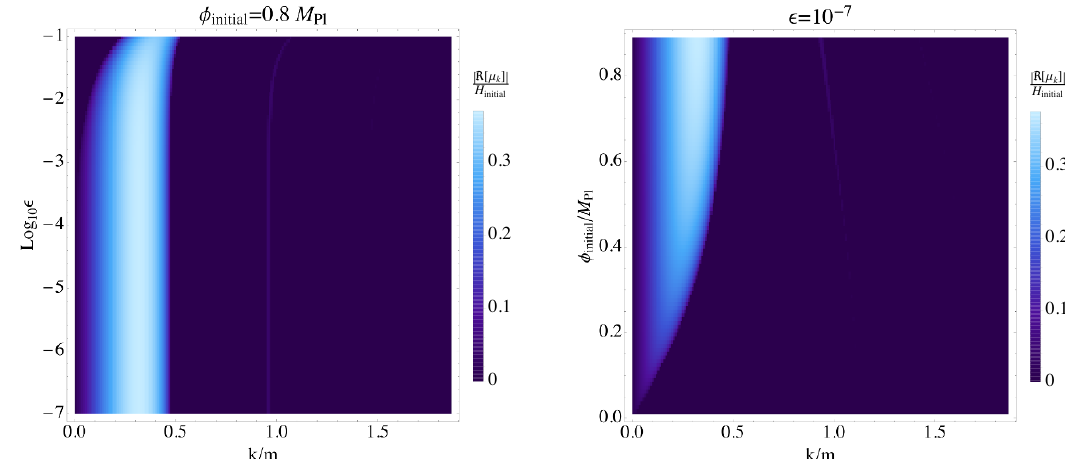
Figure 22 . Results of a Floquet analysis of the Fibre in(cid:13)ation potential. Left: the real part of the Floquet exponent j< [ (cid:22) k ] j =H initial as a function of k=m and (cid:15) Right: j< [ (cid:22) k ] j =H initial as a function of k=m and the amplitude of oscillation of the (cid:12)eld (cid:30) initial . One can see that in none of the cases j< [ (cid:22) k ] j =H initial > 0 : 4 which is a strong indication that no signi(cid:12)cant growth of (cid:13)uctuations occurs in an expanding